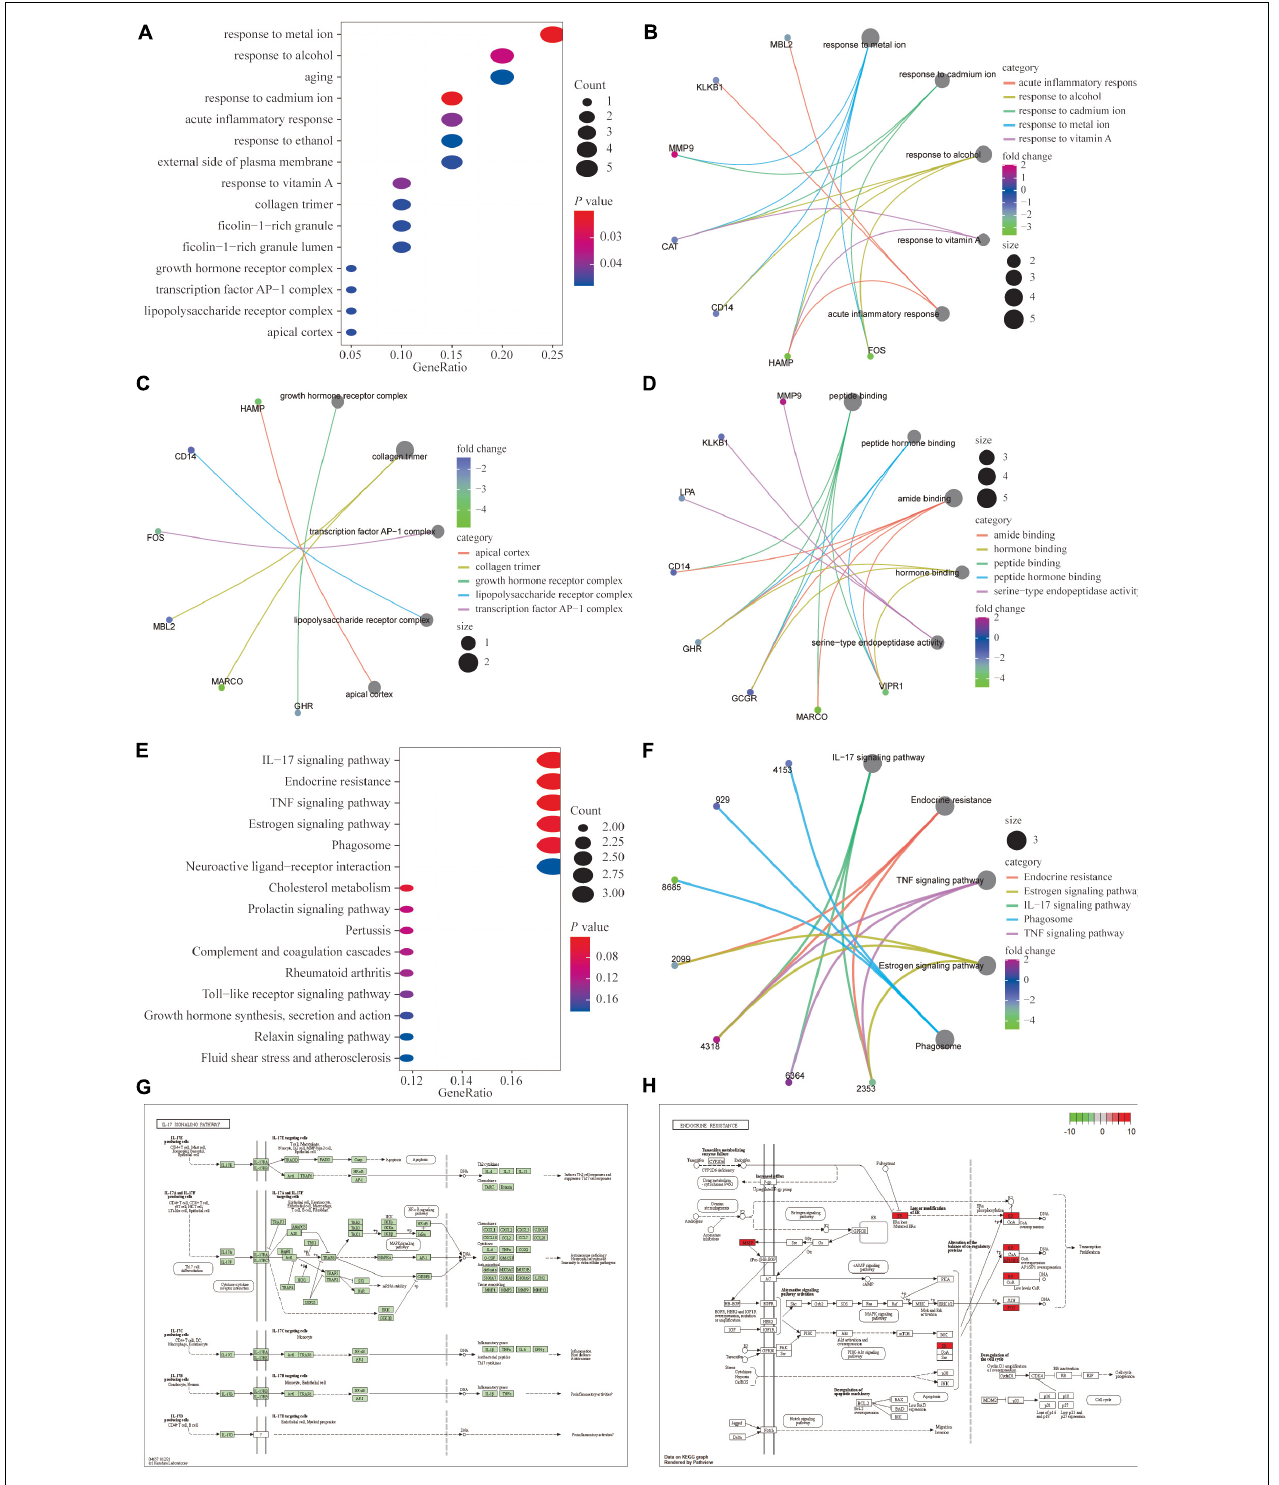
FIGURE 2 | Functional enrichment analysis of the 20 differentially expressed IRGs. (A–D) Gene ontology (GO) analysis showed that the differentially expressed genes (DEGs) were closely associated with biological processes such as responses to metal ion, response to cadmium ion, growth hormone receptor complex, collagen trimer, and peptide binding. (E,F) Kyoto encyclopedia of genes and genomes (KEGG) functional analysis suggested that differentially expressed immune genes mainly affected the IL-17, endocrine resistance, TNF and estrogen signaling pathways. (G,H) Detailed demonstrations of the IL-17 and endocrine resistance